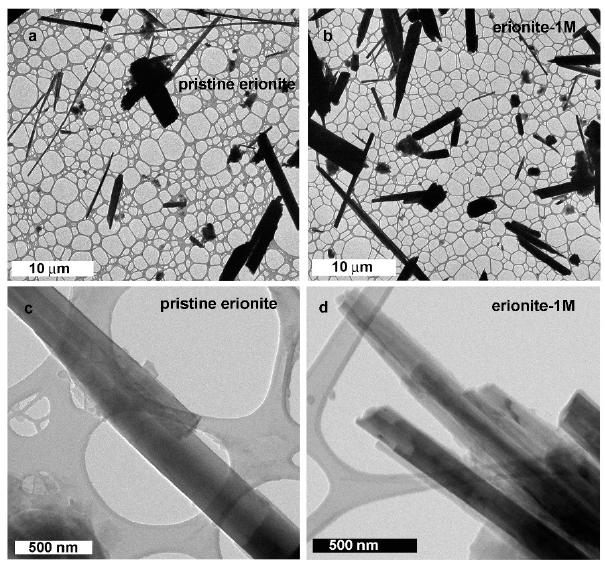
Figure 5. Bright-field TEM images of pristine erionite ( a , c ) and erionite after 1 month of incubation ( b , d ).